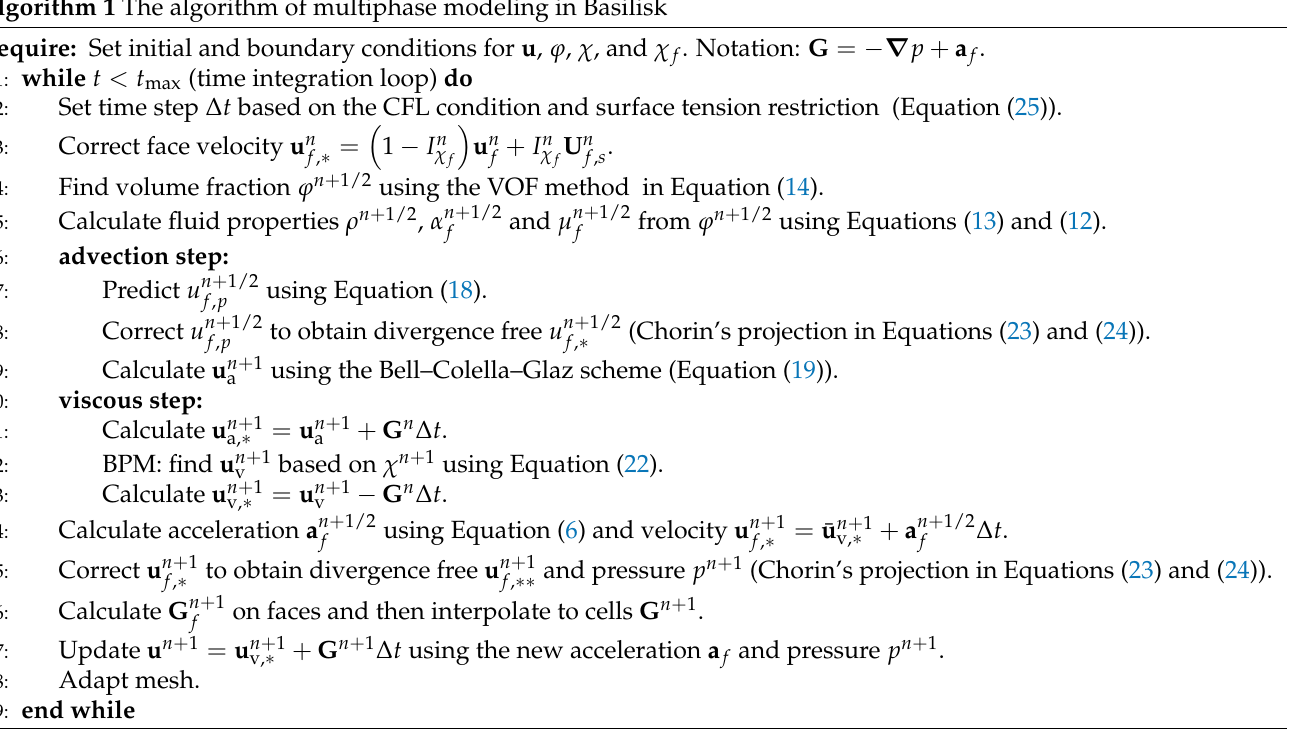
Algorithm 1 The algorithm of multiphase modeling in